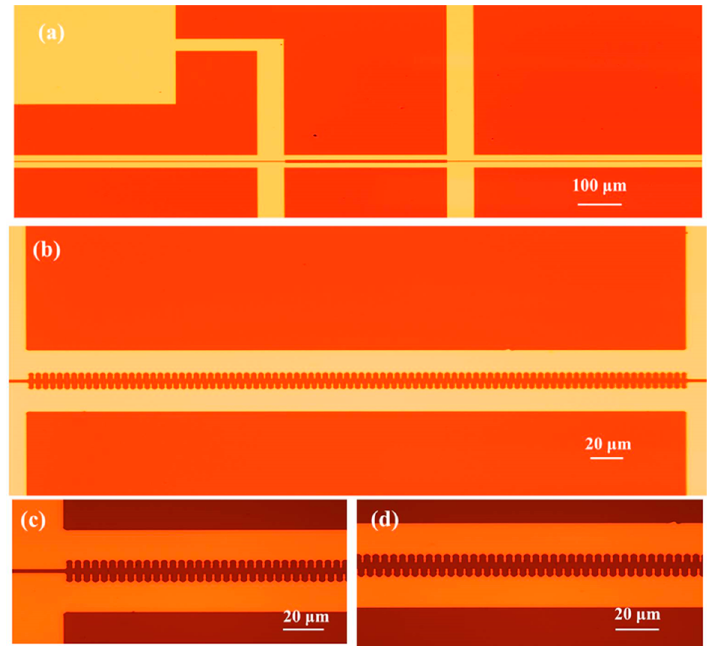
Figure 11. ( a ) Top view of the electrode measured by optical microscope (×100); ( b ) morphology of grating region (×200); ( c ) Appearance of the grating at the beginning (×500); ( d ) Appearance of the grating at the center (×500).